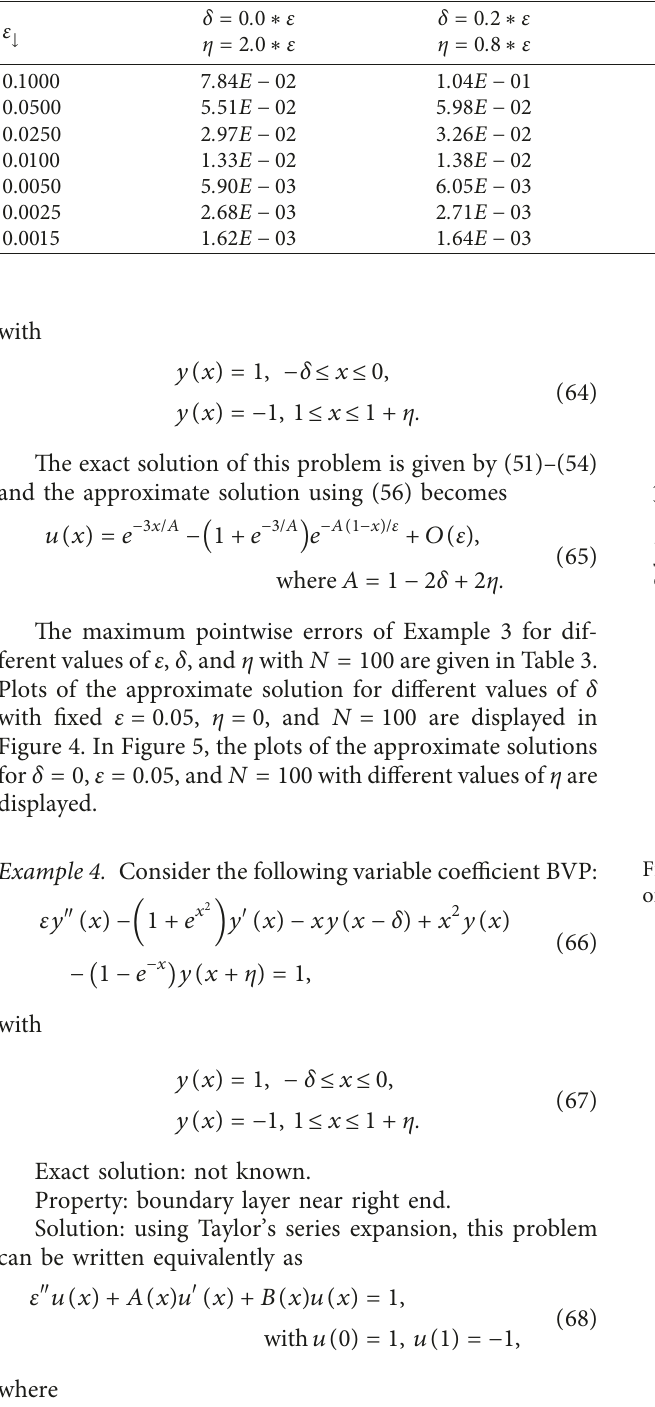
Table 3: Result for Example 3 (max. errors for N � 100).